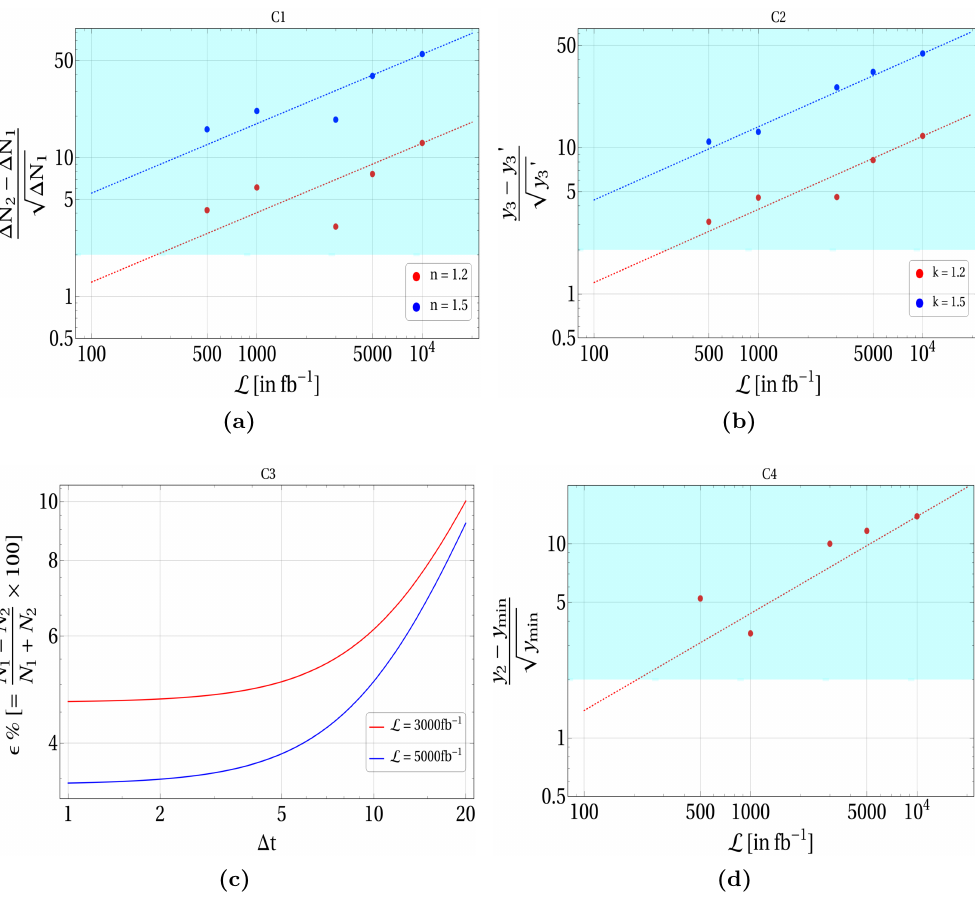
Figure 20. Same as figure 19 but for